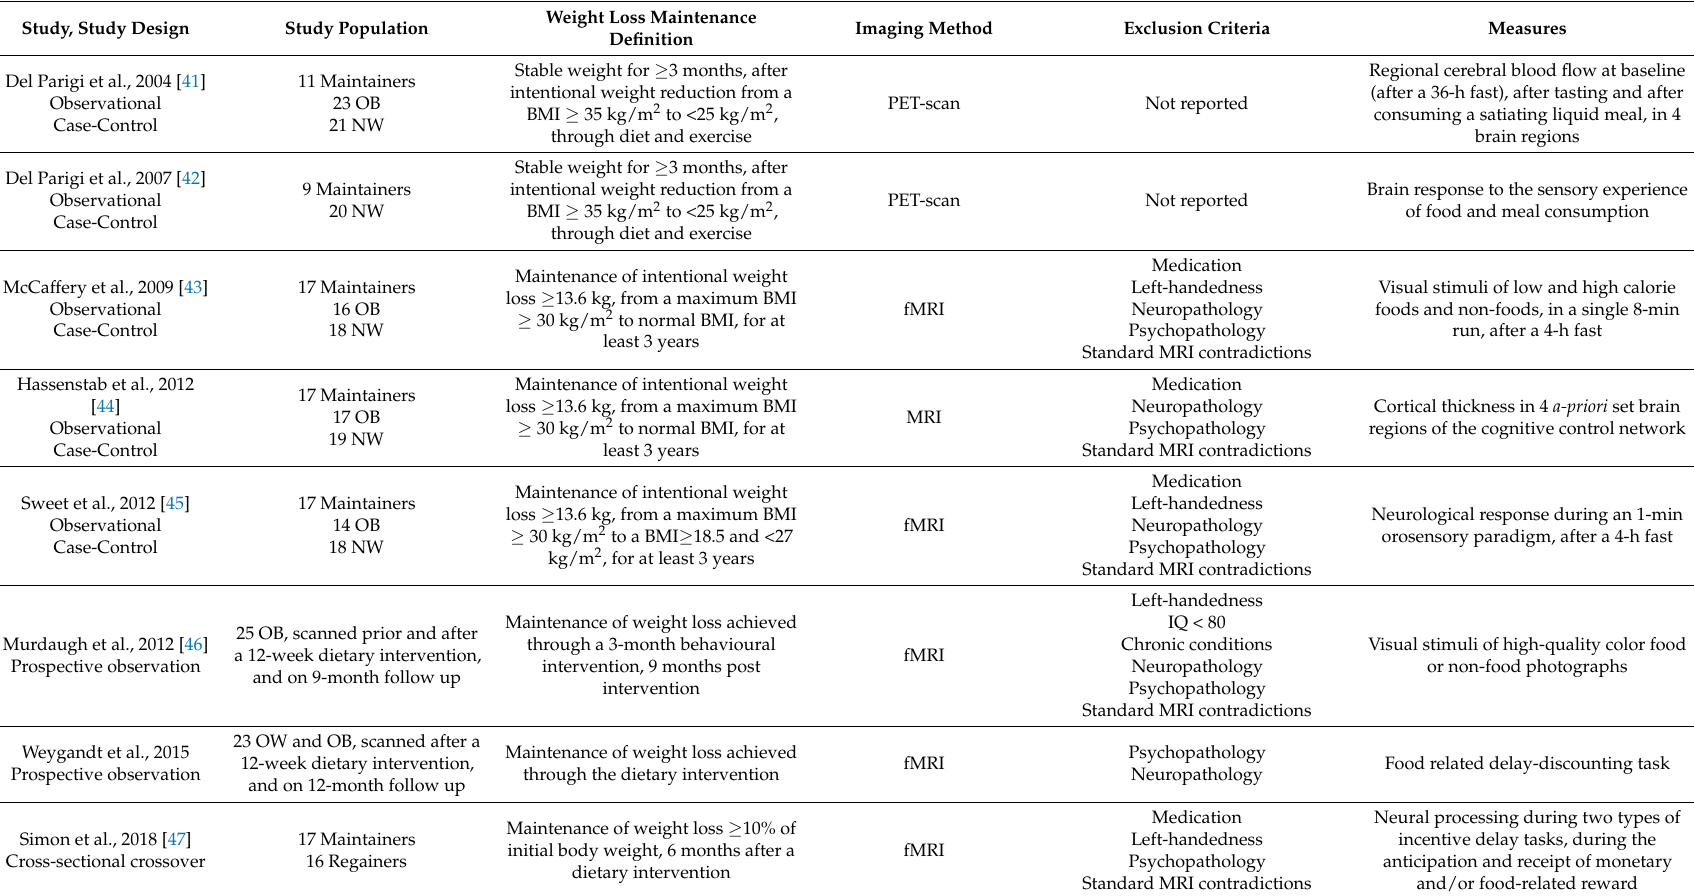
Table 1. Descriptive characteristics of the reviewed neuroimaging studies ( n =